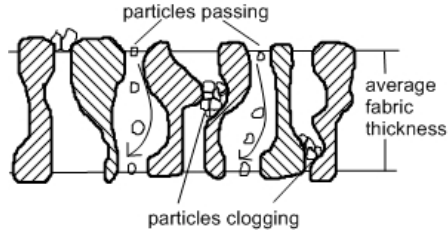
Figure 3. Geotextile clogging.